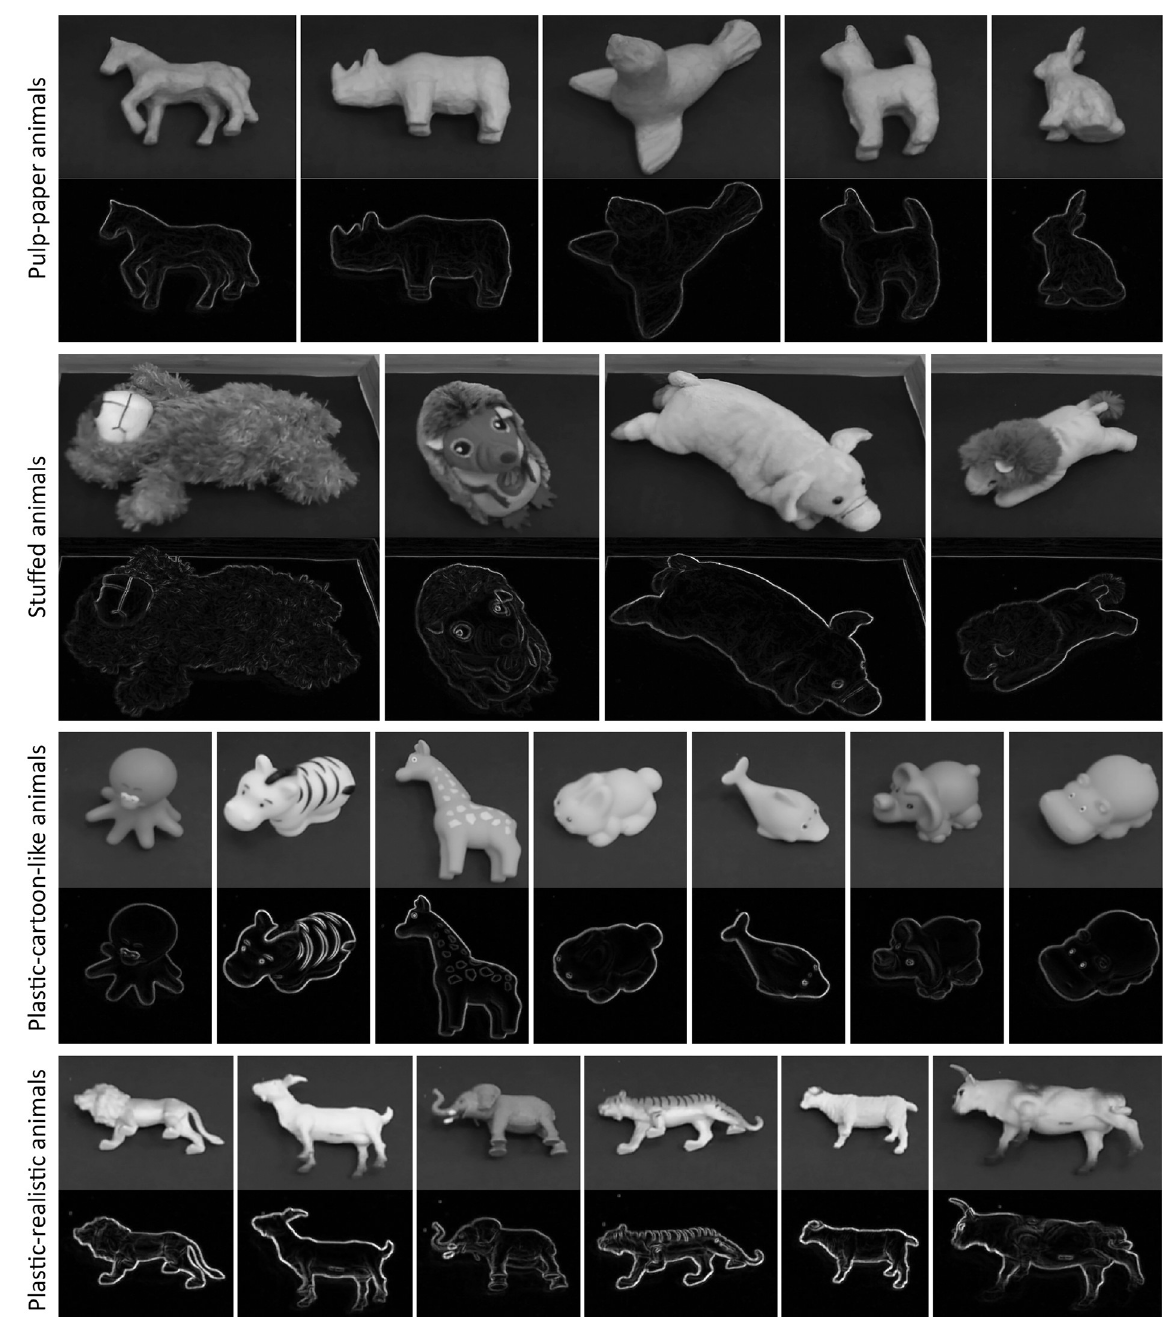
Fig 7. Gray-scale images and contour-drawings of several samples taken from the 4 collections of animal toys used in Experiment 2. There were 2 groups of 6 participants. The first group ran the block with the contour-draw- ing filter first. This was followed by the block with the grayscale-images. The second group ran the blocks in the opposite order. The participants rested for 5 minutes between blocks. They did nor wear our AR device during these rest periods.